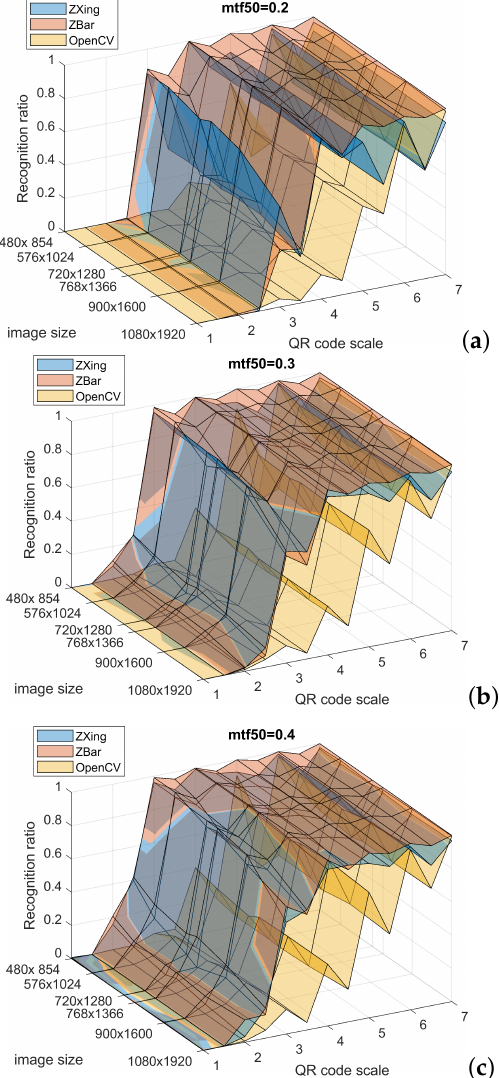
Figure 9. Recognition ratio for detect and decode for: ( a ) MTF50 = 0.2, ( b ) MTF50 = 0.3, ( c ) MTF50 =